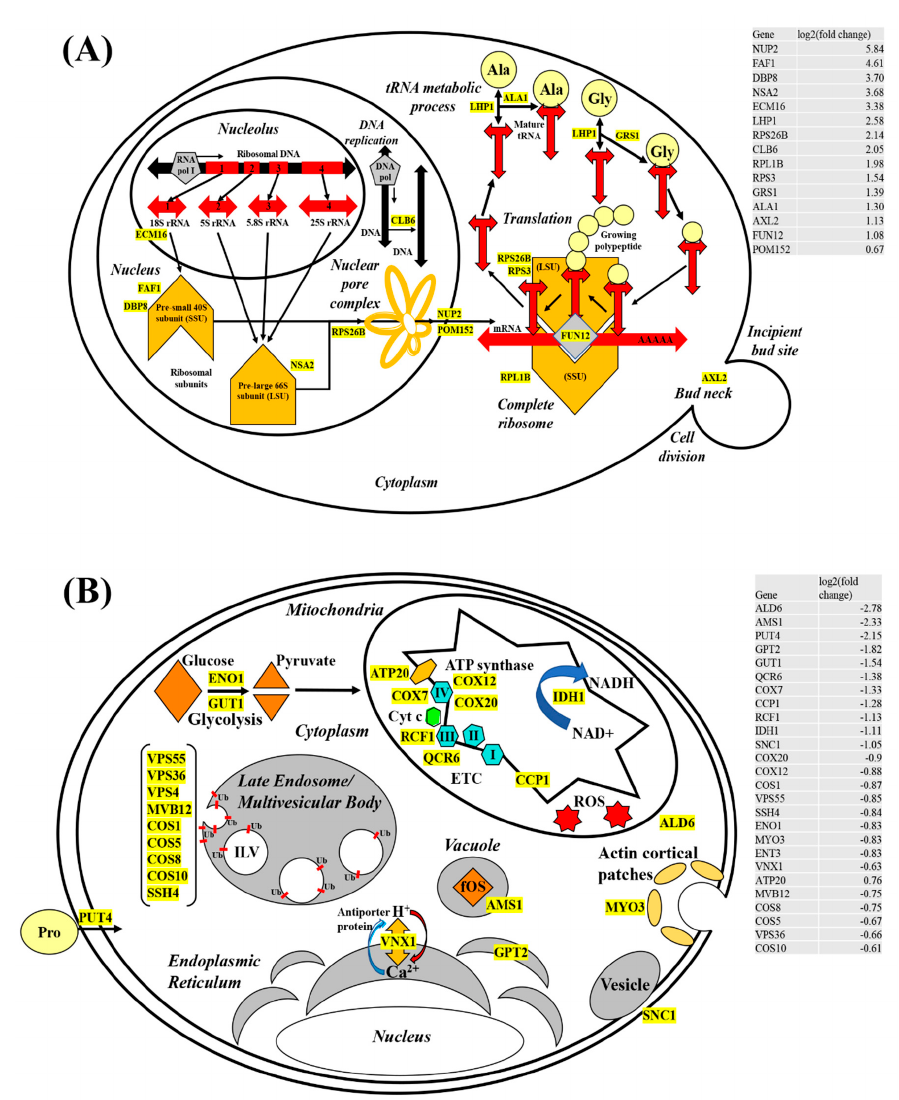
Figure 7. Schematic models of changes in cellular processes with CdSe/ZnS-QDs in yeast cells. Genes are strategically placed near representative illustrations they are thought to be involved in. ( A ) CdSe/ZnS leads to an increase in the expression of genes implicated in the pre-ribosomal assembly of small and large subunits and their nuclear export as well as maturing tRNA and complete ribosomes. ( B ) Several processes appear to be affected by exposure to CdSe/ZnS, including cell wall/membrane integrity, sugar import (see the main text), late endosome/multivesicular body function, and cellular respiration in the mitochondria.